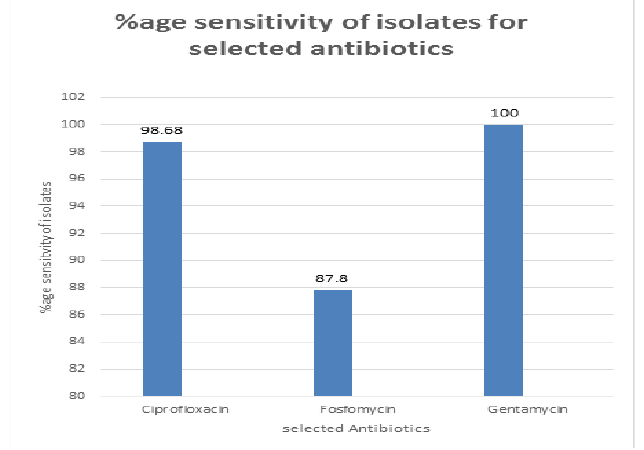
Fig. 14 Percentage sensitivity of